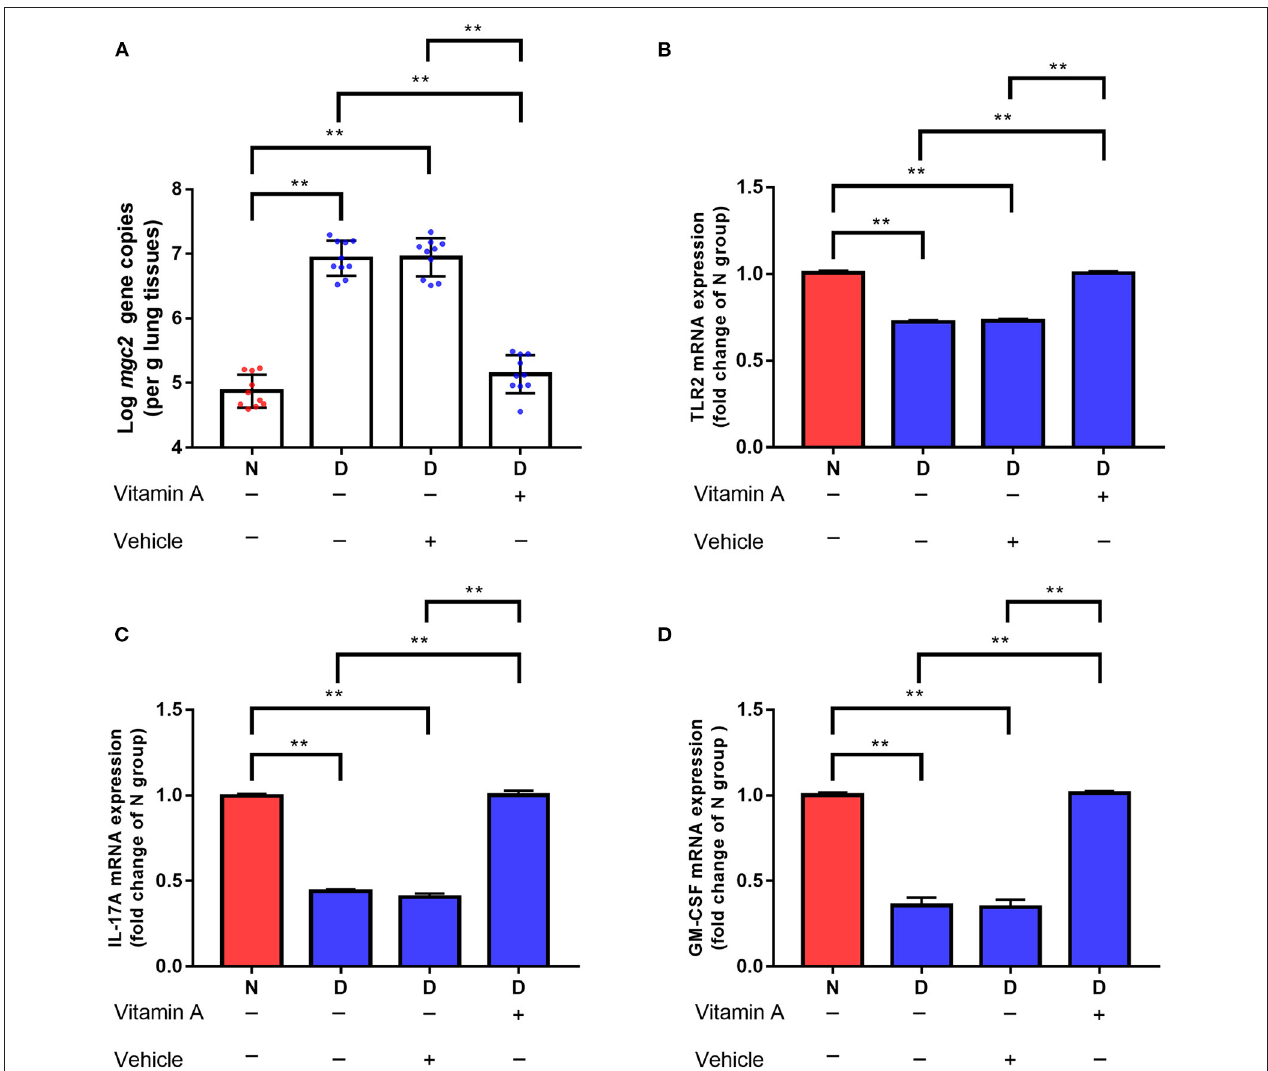
FIGURE 6 | Effects of vitamin A supplementation on MG colonization in lung of gut microbiota dysbiosis group. (A) Mgc2 gene copies in chicken lung after MG infection ( n = 10). (B) TLR2 mRNA expression levels in chicken lung after MG infection ( n = 6). (C) IL-17 mRNA expression levels in chicken lung after MG infection ( n = 6). (D) GM-CSF mRNA expression levels in chicken lung after MG infection ( n = 6). Indicated groups were orally administered vitamin A at 250 IU/kg feed from day 48 to day 51 showed in Figure 1 . **Indicates P <